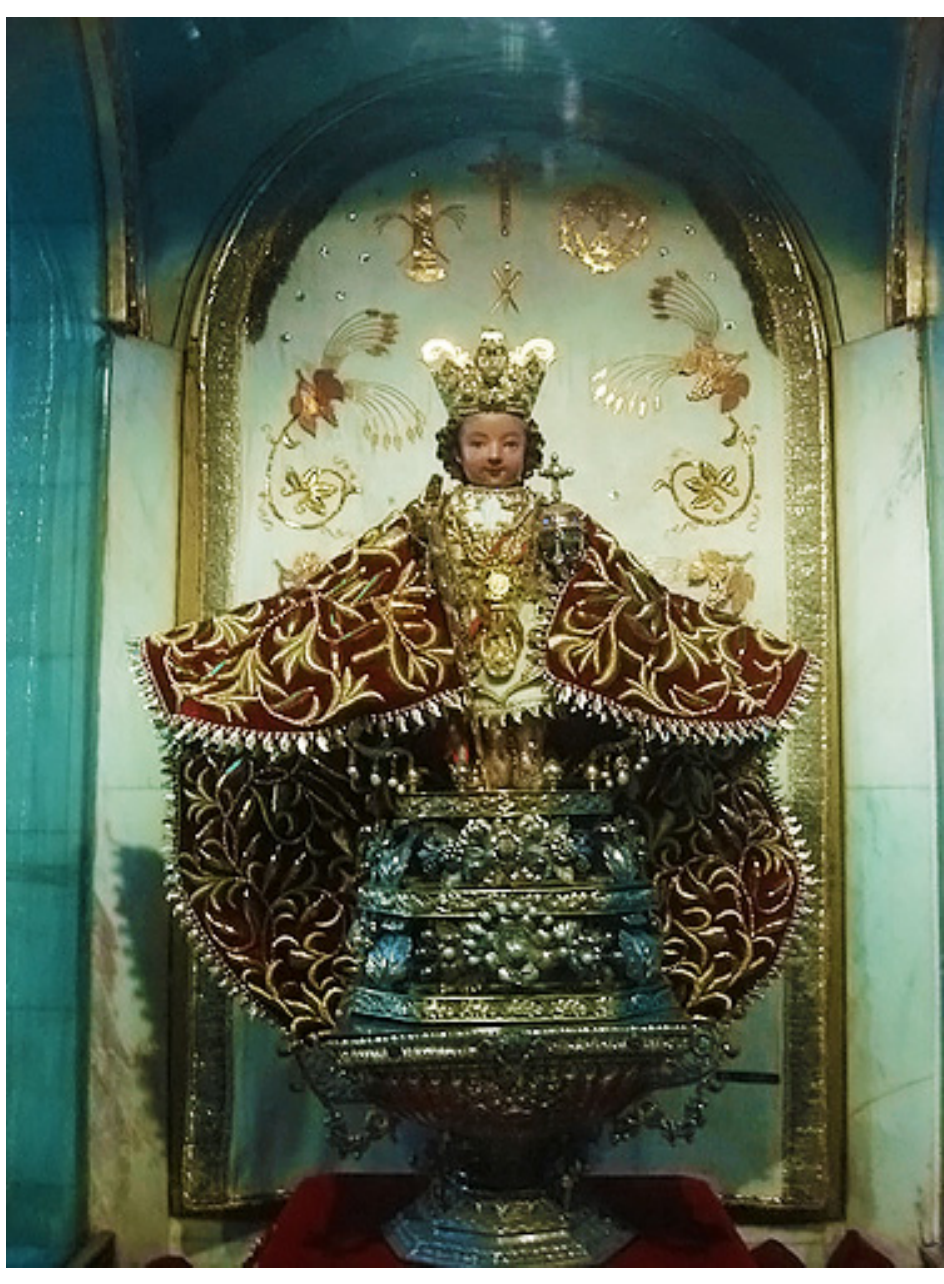
Figure 1. The Santo Niño de Cebu on its niche within the Basilica Minore del Santo Niño de Cebu. Source: Wikimedia Commons, photo by Puertopalomar.